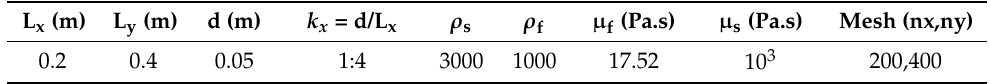
Table 2. Parameters used in the first modeled scenario.